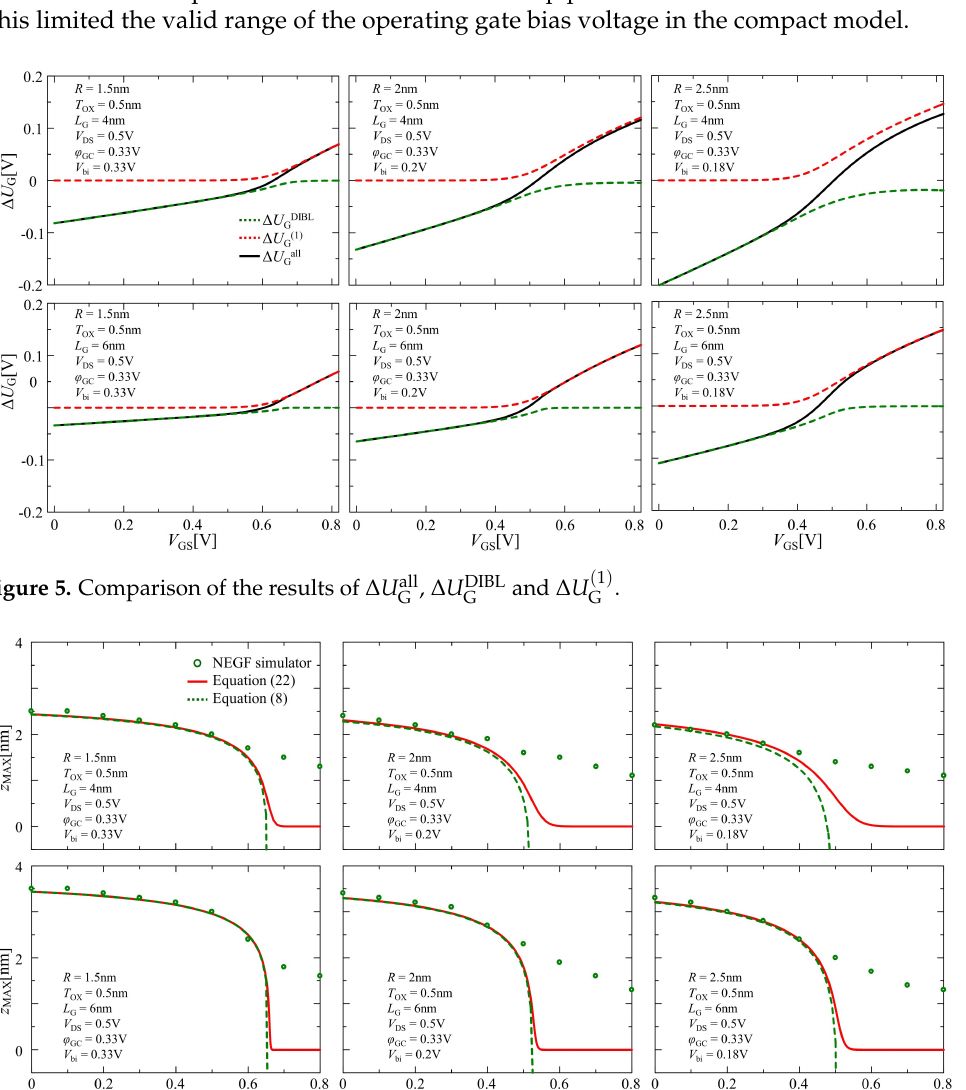
Figure 6. Gate bias dependence of the potential barrier top position along the channel calculated with the NEGF simulation (open circle) and our compact model using Equations (8) (dashed line) and (23) (solid